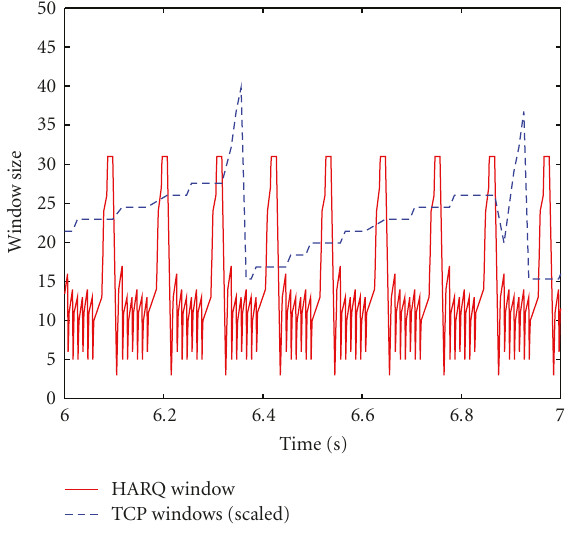
Figure 10: Zoom of Figure 9.